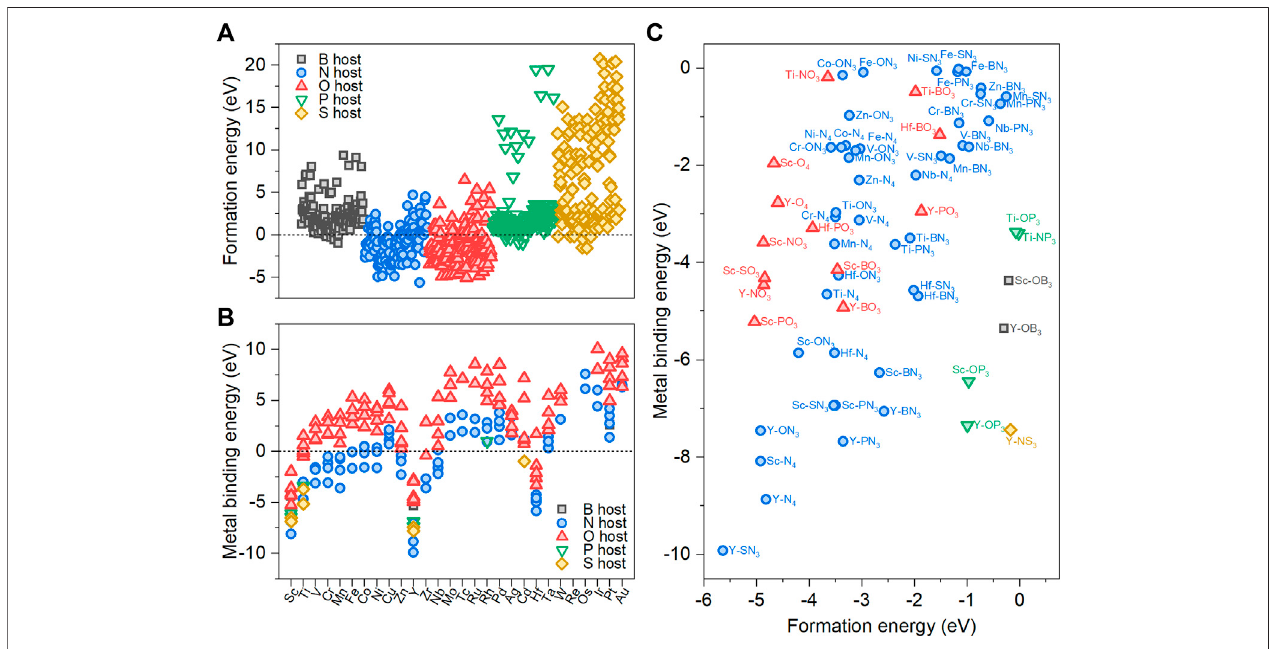
FIGURE 2 | (A) Formation energies ( E form ) of 700 M-YX 3 . (B) Metal-binding energies ( E b ) of 222 M-YX 3 with negative E form as a function of transition metals. (C) Stable 66 M-YX 3 structures with both negative E form and negative E b